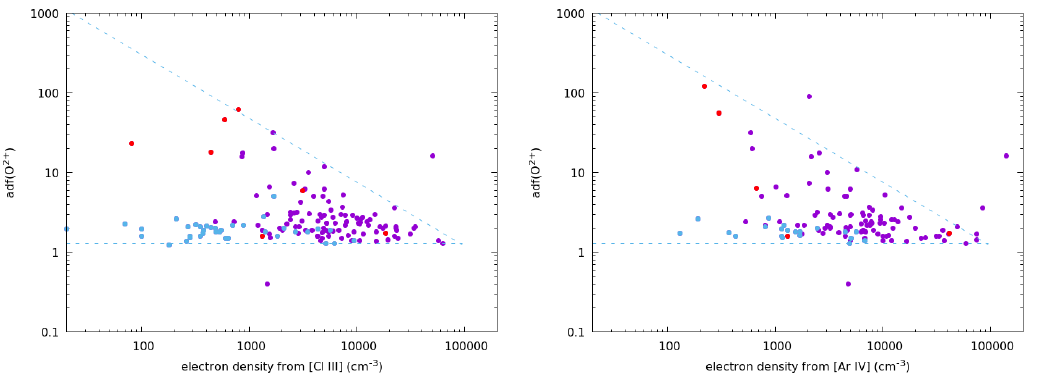
Figure 5. adf against electron density estimated from [O II ] ( top left ), [S II ] ( top right ), [Cl III ] ( bottom left ) and [Ar IV ] ( bottom right ) line ratios. Planetary nebulae with binary central stars are shown with red points; other PNe are shown with purple points; and H II regions are shown with light blue points. Dashed lines indicate the empirical limits inside which almost all objects are found (see the text for